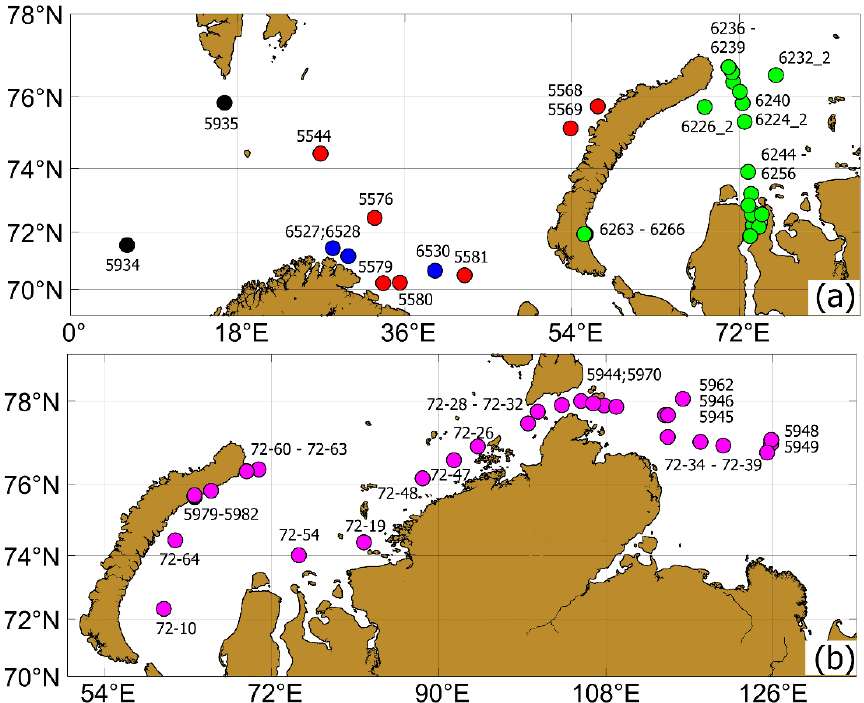
Figure 1. Location of the selected stations: ( a )—AMK-65 (blue), AMK-68 (red), AMK-71 (black), AMK-76 (green), ( b )—AMK-72 (magenta).